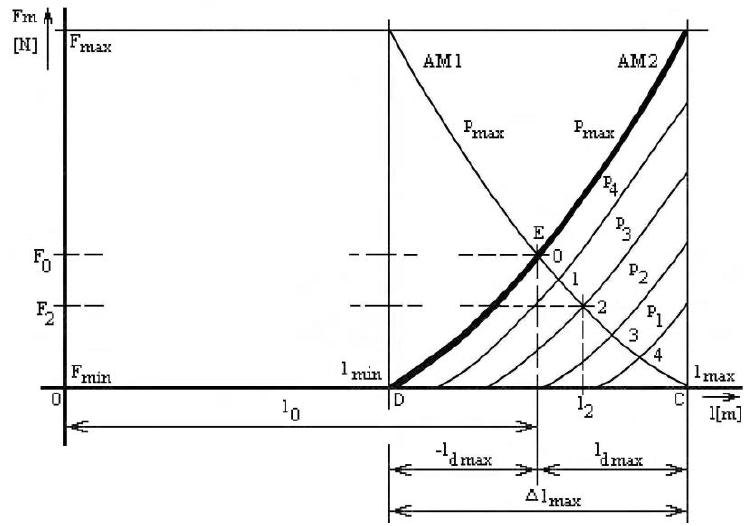
Figure 5. Static properties of PAMs in antagonistic connection at variable filling pressure.